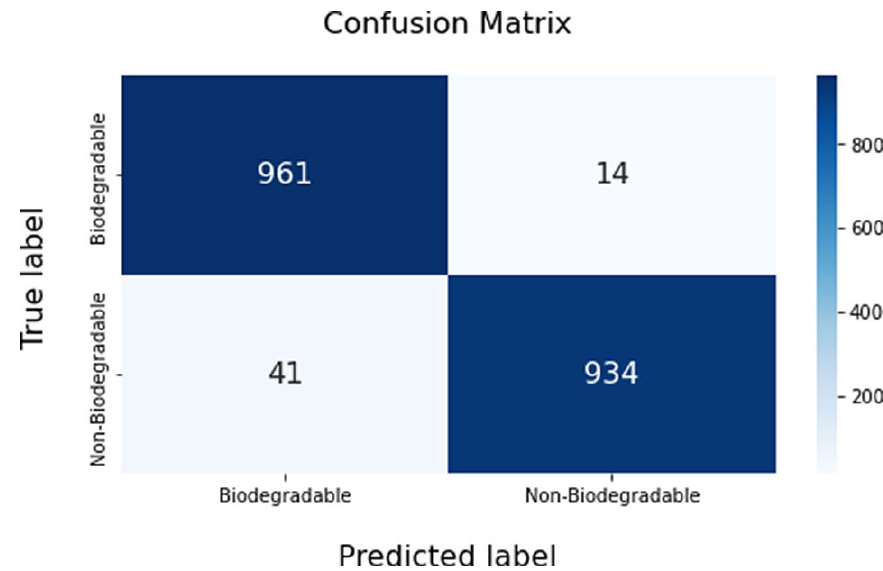
Fig. 5. Confusion matrix with true vs predicted label for